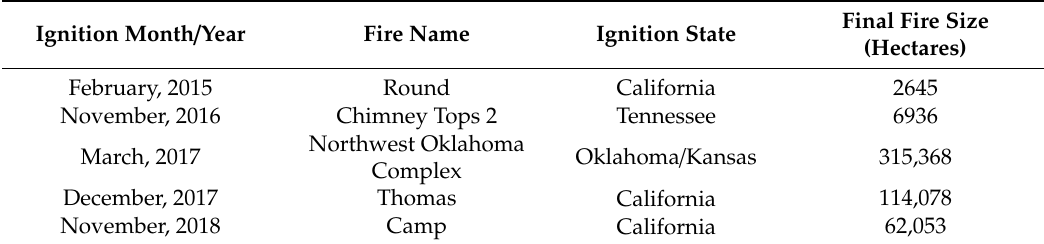
Table 1. Selected examples of destructive “o ff -season” wildfires, illustrating the shift from a “fire season” to a “fire year” in the